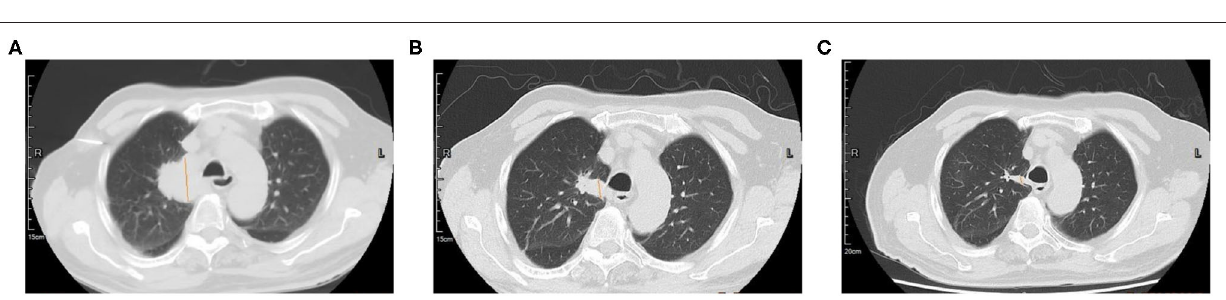
FIGURE 4 | Computed tomography (CT) scan of the primary lung lesion before and after crizotinib treatment. (A) In November 2020, the tumor size was 55 × 43mm; (B) In January 2021, the tumor size was 26 × 17mm; (C) In May 2021, the tumor size was 27 ×